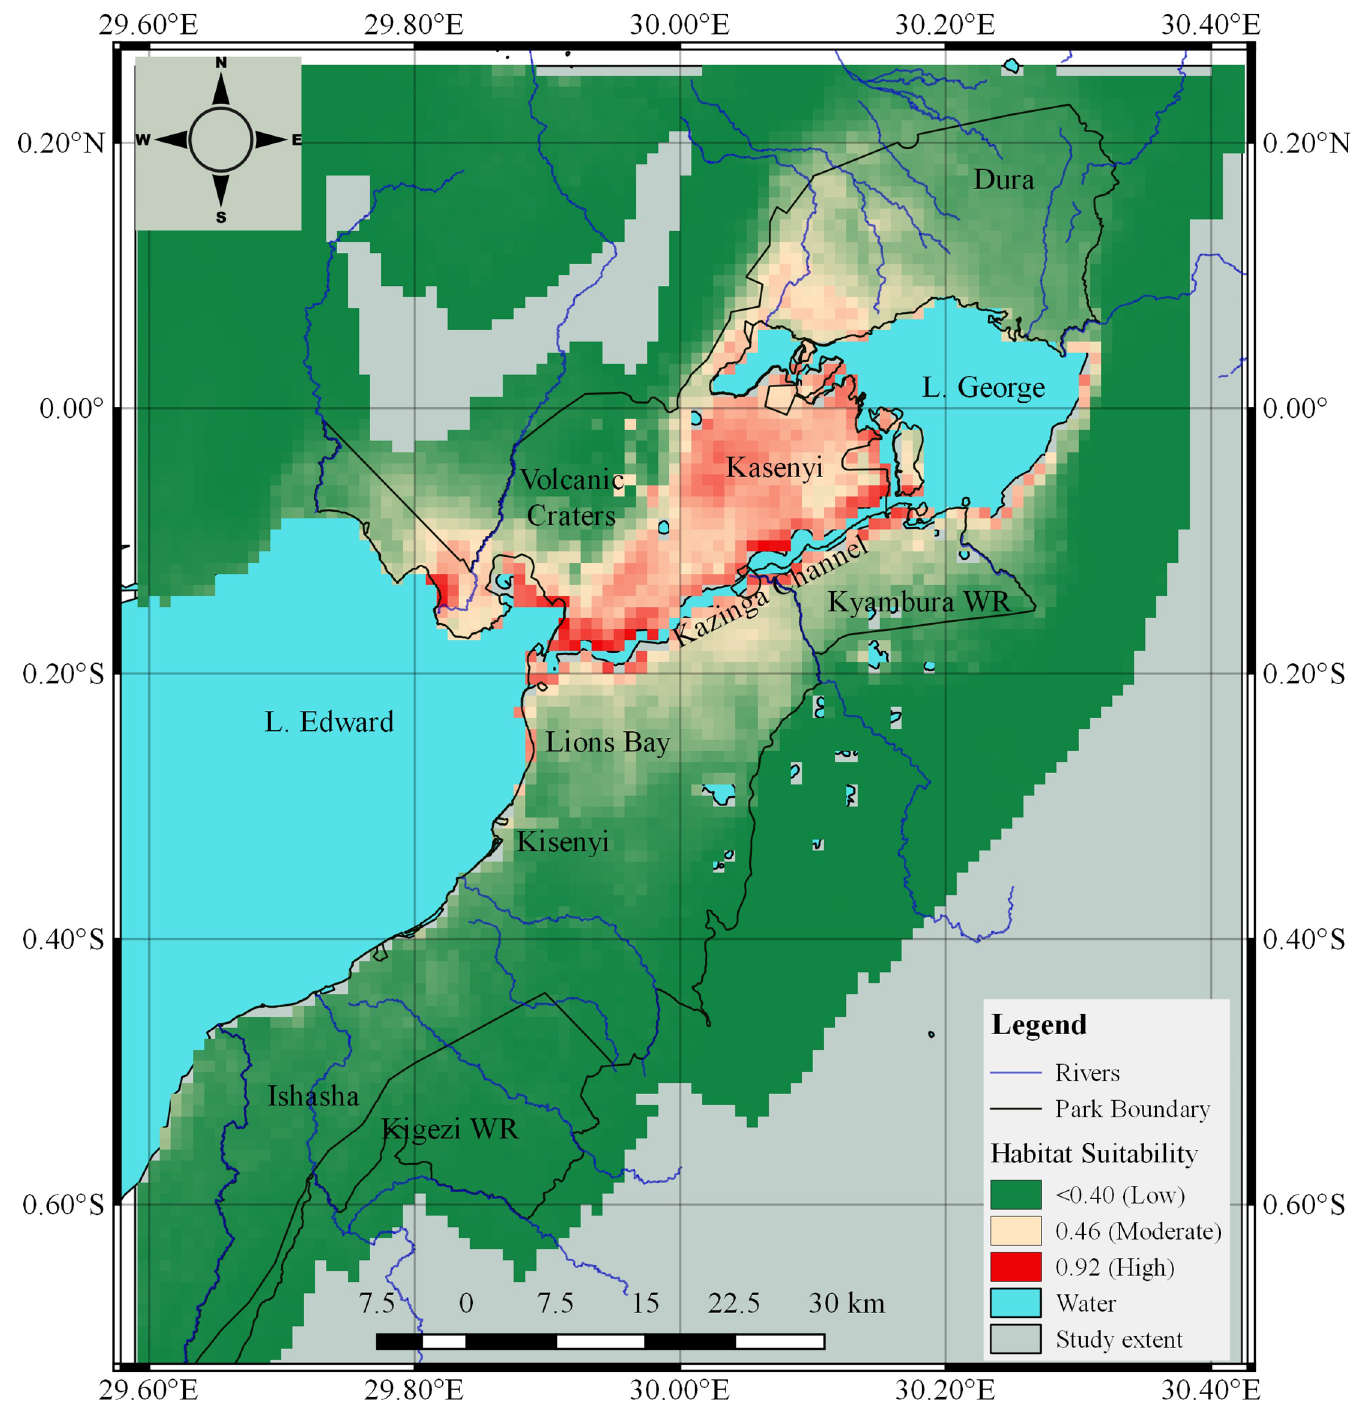
Fig 5. Predicted probability map showing habitats with suitable environmental conditions favouring Bacillus anthracis distribution in QEPA ecosystem. Red colour (0.927) shows areas with the highest probability of suitable conditions for anthrax occurrence, and green ( < 0.4) indicates areas predicted as least suitable sites. Predictor variables used for modelling obtained from WorldClim (http://worldclim.org/version2), and ISRIC online resources (https://www.isric.org/projects/soil- property-maps-africa-20-m-resolution), with kind permission of Dr. Stephen Fick, geo-spatial data scientist and Niels Batjes, Senior Soil Scientist and Coordinator of the World Data center for soils at ISRIC–World Soil